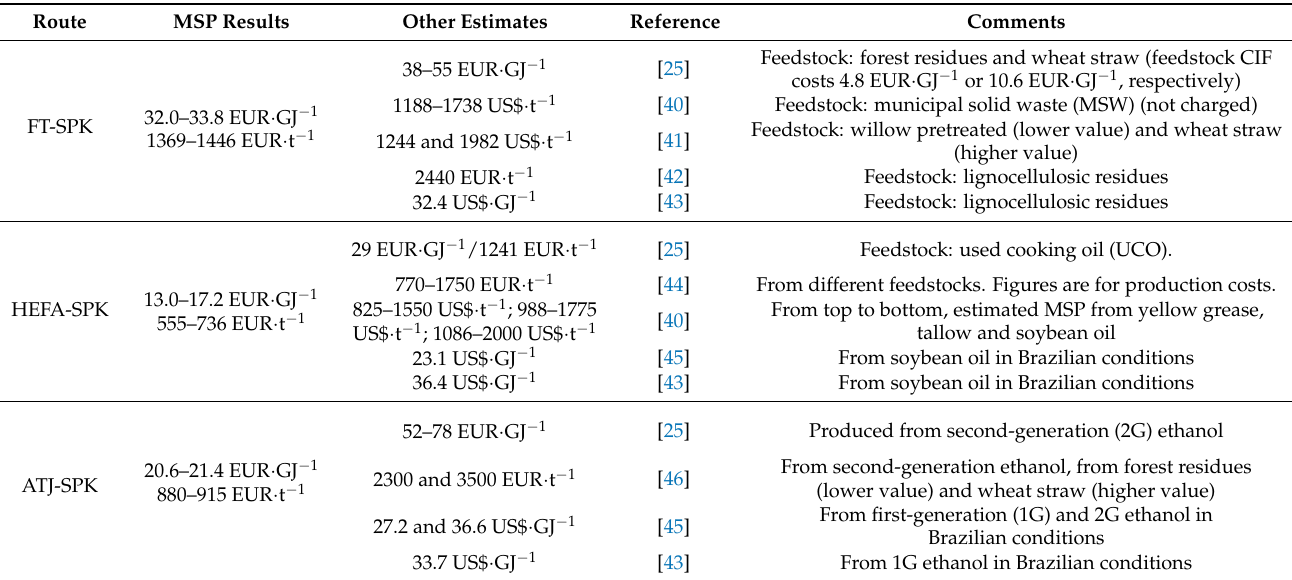
Table 6. The MSP results presented in this paper and comparisons with the equivalent estimates available in the literature. Route MSP